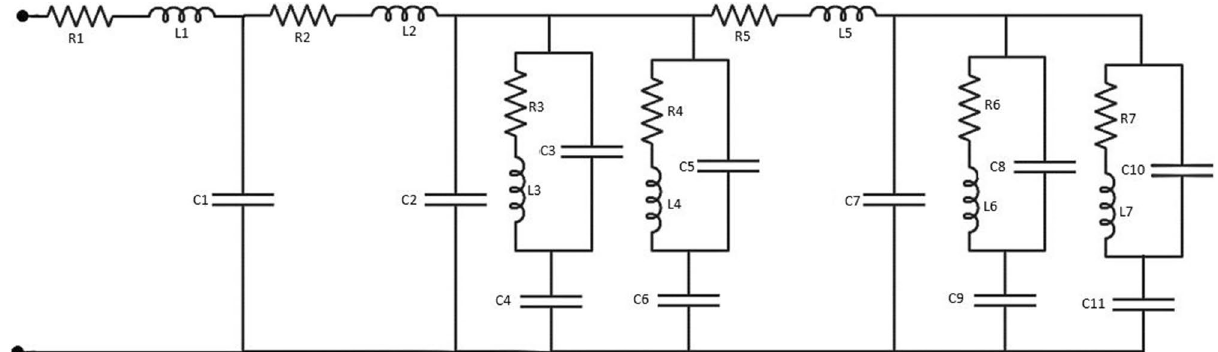
Figure 5. Equivalent circuit of the proposed